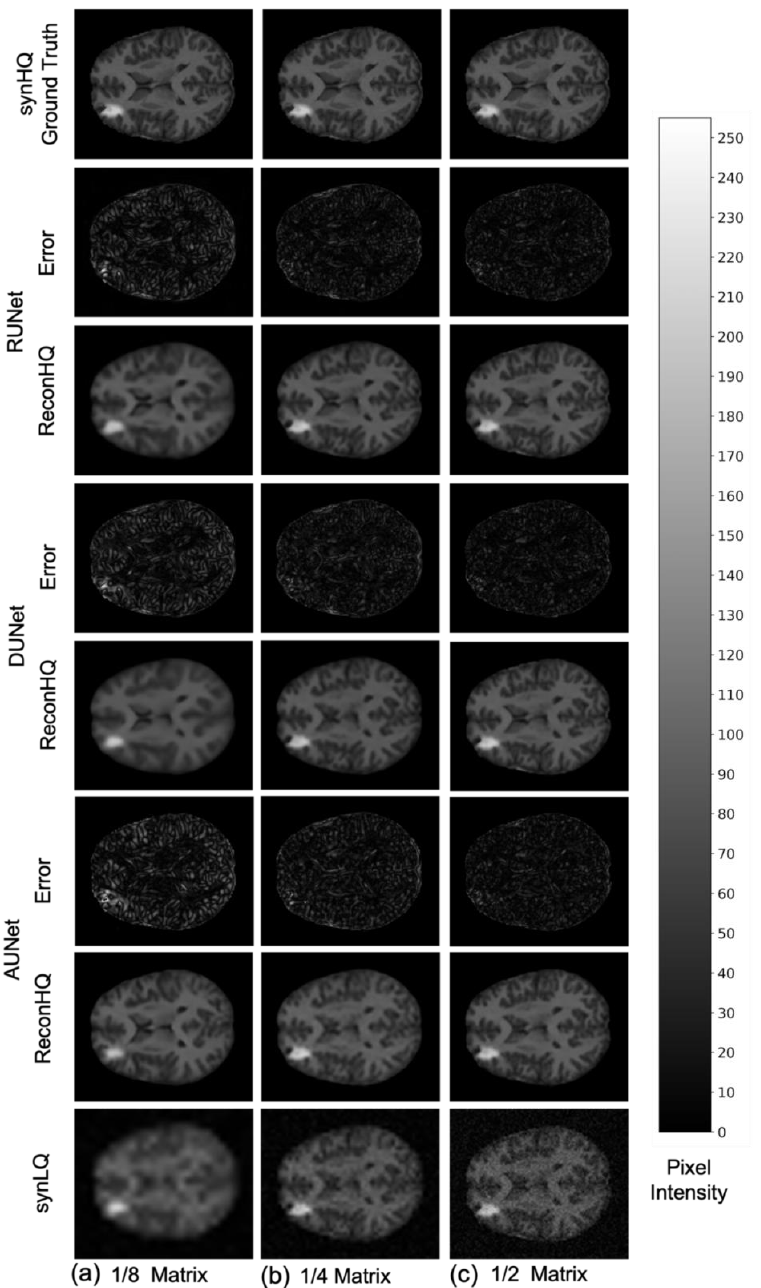
Figure 8. Representative example of reconstructed images and errors versus ground truth with the three UNets trained for 100 epochs with the WithOut-Prior acquisition scenario (i.e., not including the augmMRI) to upscale ( a ) 1/8 downsampled (22 × 26) and ( b ) 1/4 downsampled (44 × 52) and ( c ) 1/2 downsampled (88 × 104) synLQ. The error intensity in this figure is three times the original in- tensity.